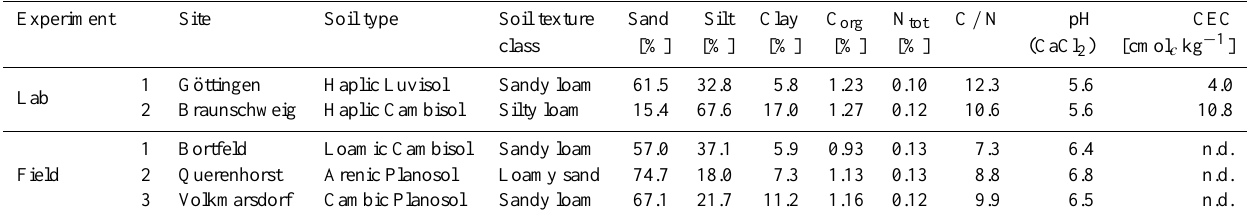
Table 2. General properties of the soils used for the lab and field study (n.d. indicates not determined). Experiment